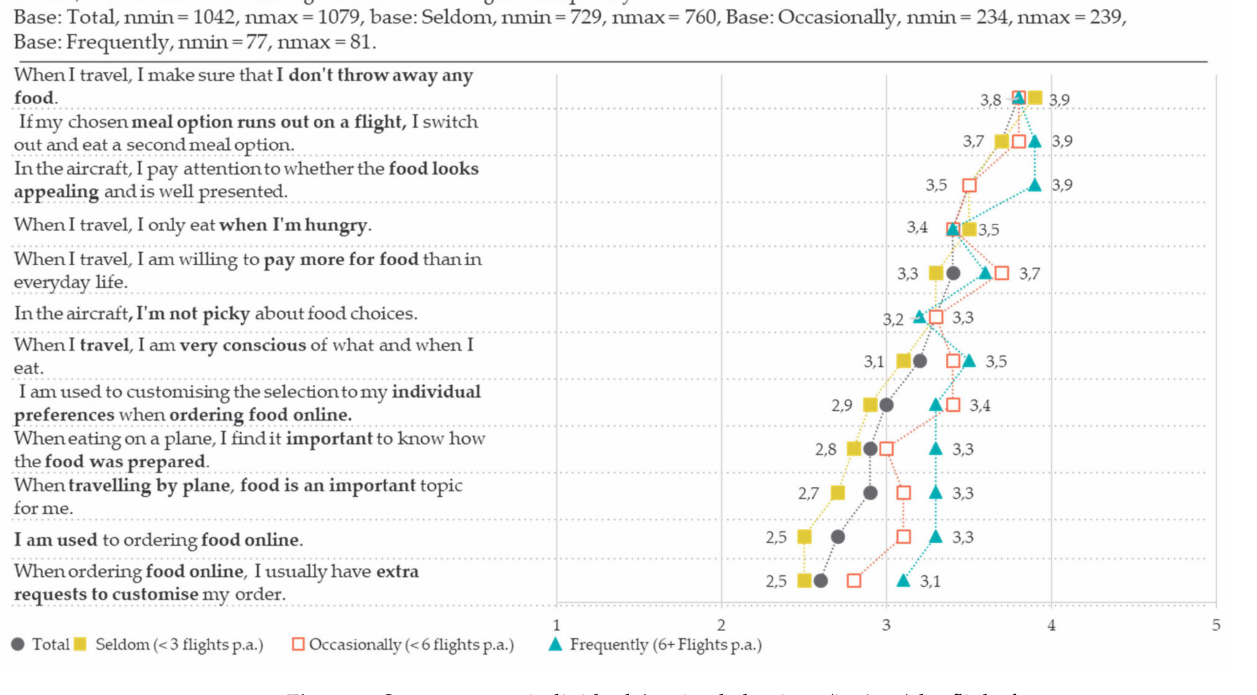
terms of their eating habits than other age groups, as shown in Figure